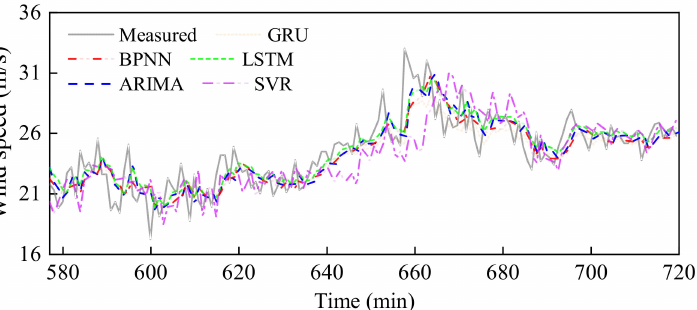
Figure 8. Performance comparison of one-step ahead forecasting by different models for the 1 min maximum wind speed.